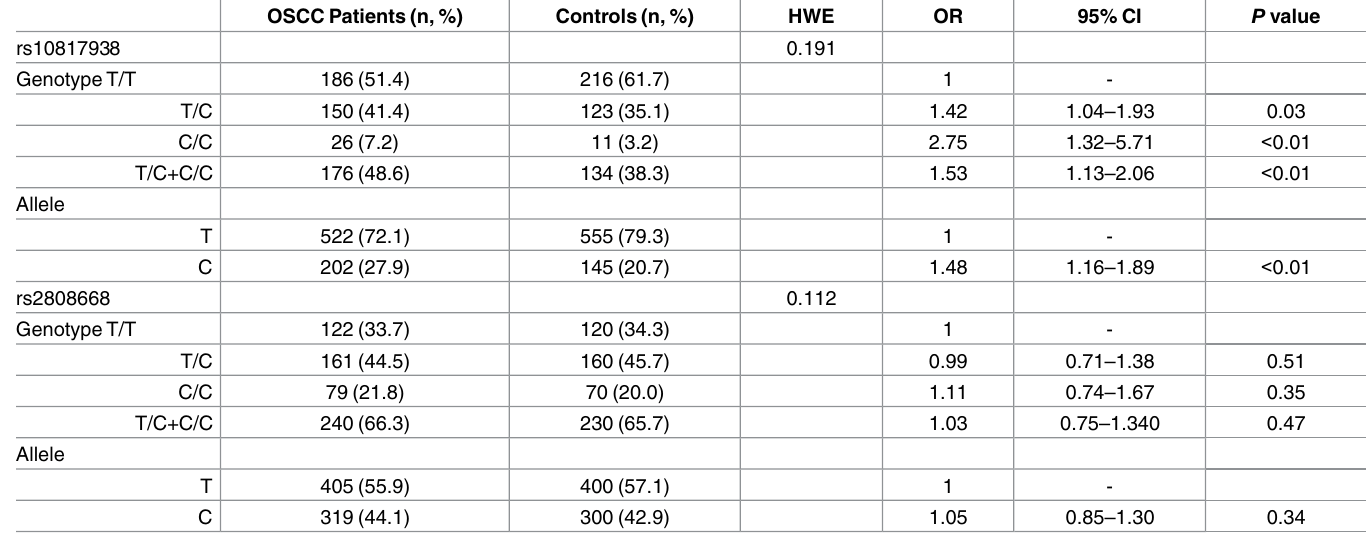
Table 2. Genotypedistribution and allelefrequencies for rs10817938 at XPA genein OSCC patientsand